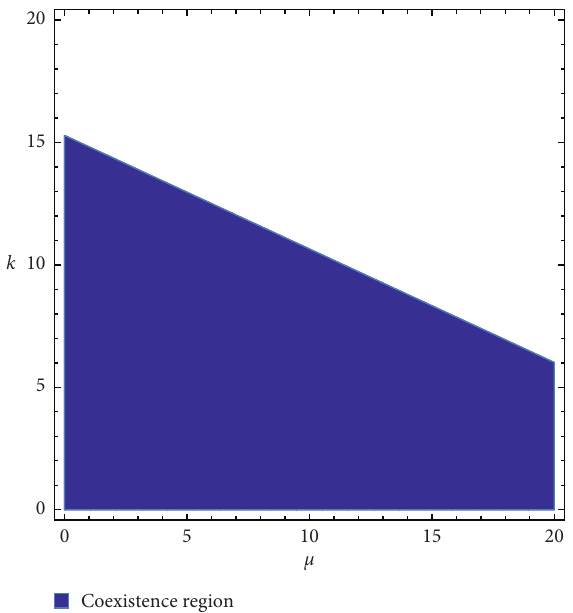
Figure 1: Coexistence region for system (4) with a � 6 . 76, b � 9 . 4, c � 1 . 58, r � 0 . 74, p � 9 . 2, and d � 8 .